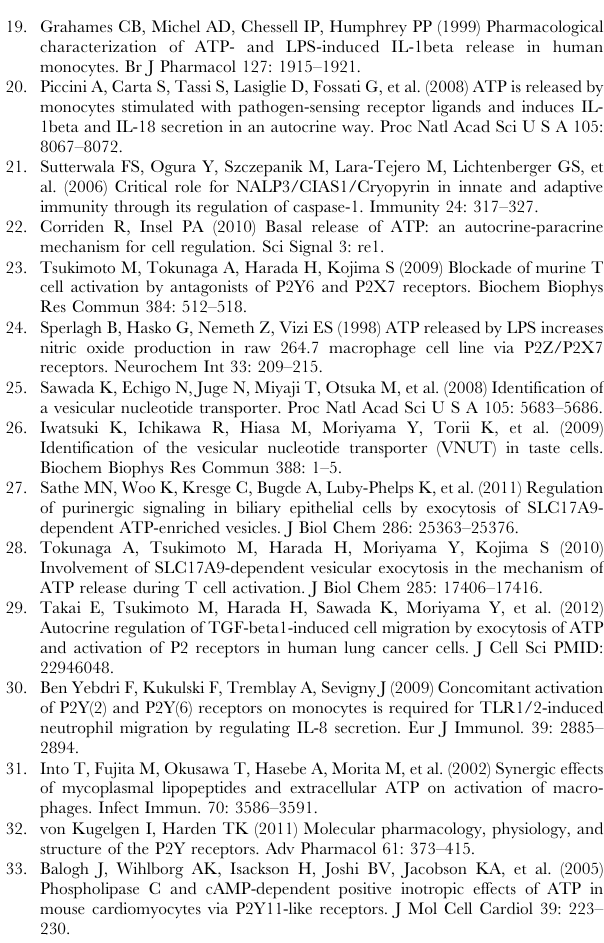
Figure S1 P2Y11 antagonist NF157 blocked ATP-in- duced increase of cAMP levels in mouse macrophage RAW264.7 cells. (A) RAW264.7 cells were incubated with 10– 100 m M of ATP for 10 min. (B) Cells were pre-incubated with NF157 (50 m M) for 30 min, and then incubated with 100 m M ATP for 10 min. Intracellular cAMP level was measured as described in Materials and Methods . Data is expressed as fold increase in cAMP compared with control. Each value represents the mean 6 SE (n= 4). A significant difference between the positive control group (ATP) and the indicated group is indicated by *(p , 0.05). (TIF)